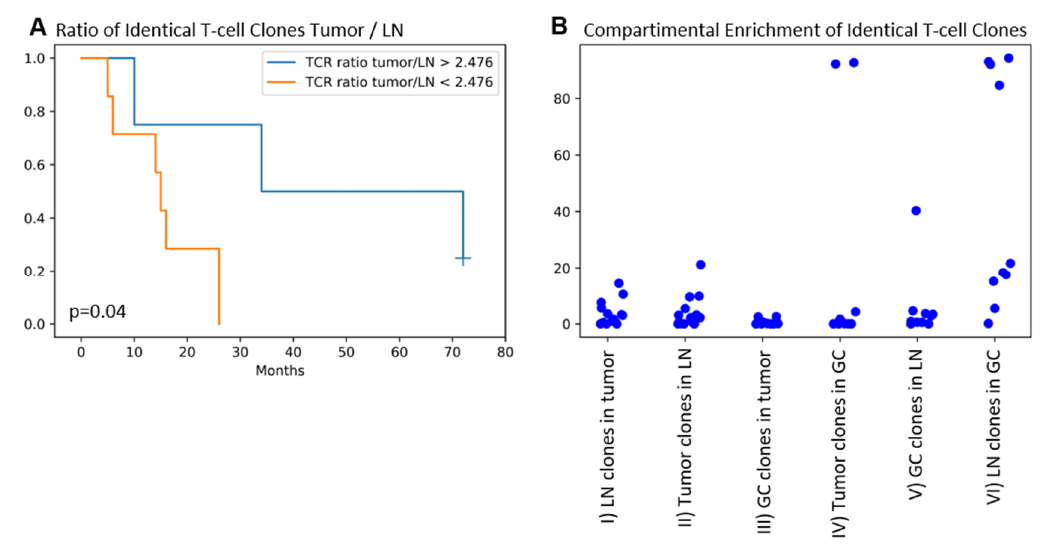
Figure 2. ( A ) Tumor/lymph node ratio of identical T-cell clones > 2.476 is associated with improved survival ( p = 0.04, logrank test, 11 deaths for 72 months follow-up observation time, 1 patient still alive in the high ratio group after 72 months follow-up; ratio was calculated as (sum of % TRG reads tumor)/(sum of % TRG reads lymph node) of identical TRG sequences from tumors and matched lymph nodes). ( B ) Displays the percentage (%) of reads (TRG sequencing) of identical clones in different compartments to see whether clones are expanded: ( I ) identical clones between draining lymph node (LN) and tumor: % reads in the tumor sample; ( II ) identical clones between tumor and draining LN: % reads in the LN sample; ( III ) identical clones between tumor and germinal center (GC): % reads in the tumor sample; ( IV ) identical clones between tumor and germinal GC: % reads in the GC sample, showing two patients with strongly enriched clones inside the GCs; ( V ) identical clones between lymph node and GC: % reads in the LN sample; ( VI ) identical clones between lymph node and GC: % reads in the GC sample.